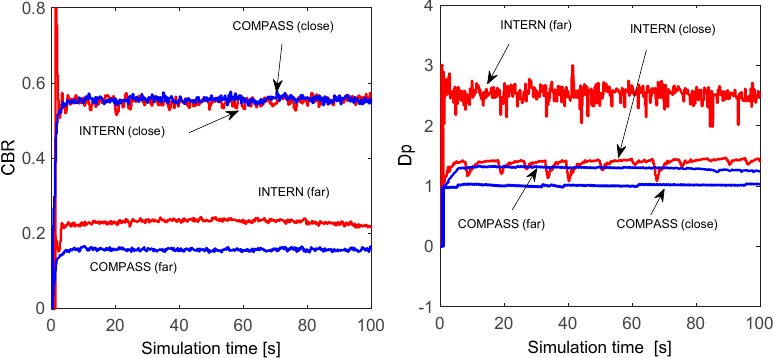
Figure 6. Time evolution of the CBR and the D p metric during a simulation run. The results are shown for two vehicles that implement INTERN (integrating A-DCC and MINT), and COMPASS (coordinating A-DCC and MINT), and a traffic density of 75 veh/km/lane.